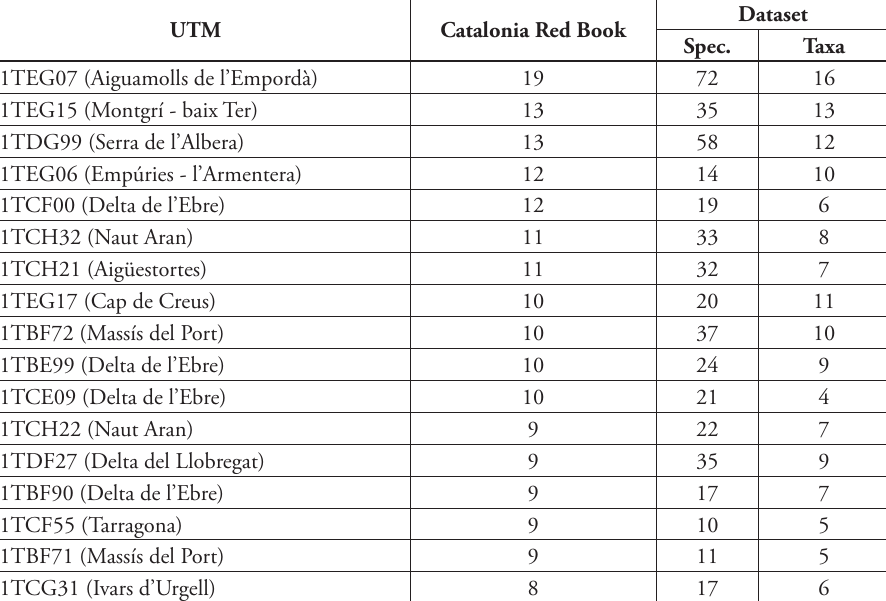
Table 7. Number of specimens and taxa of the hotspot areas defined in the Red Book of Catalonia; only squares with more than 8 taxa are recorded. UTM Catalonia Red Book